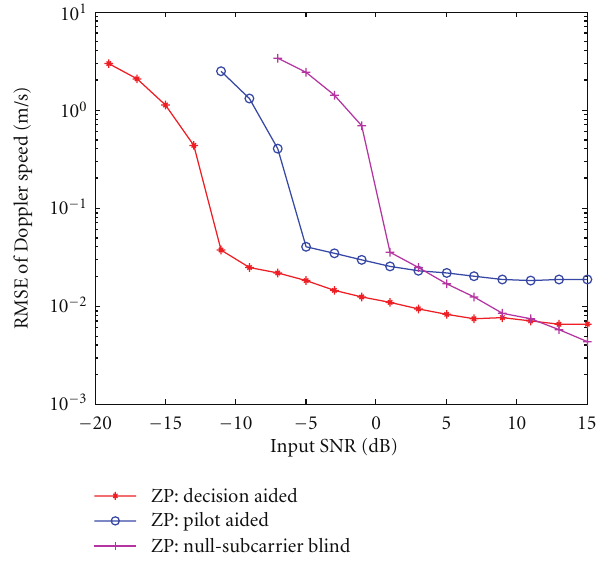
Figure 5: Performance of di ff erent estimators for ZP-OFDM in multipath channels with a common Doppler scale (channel setting